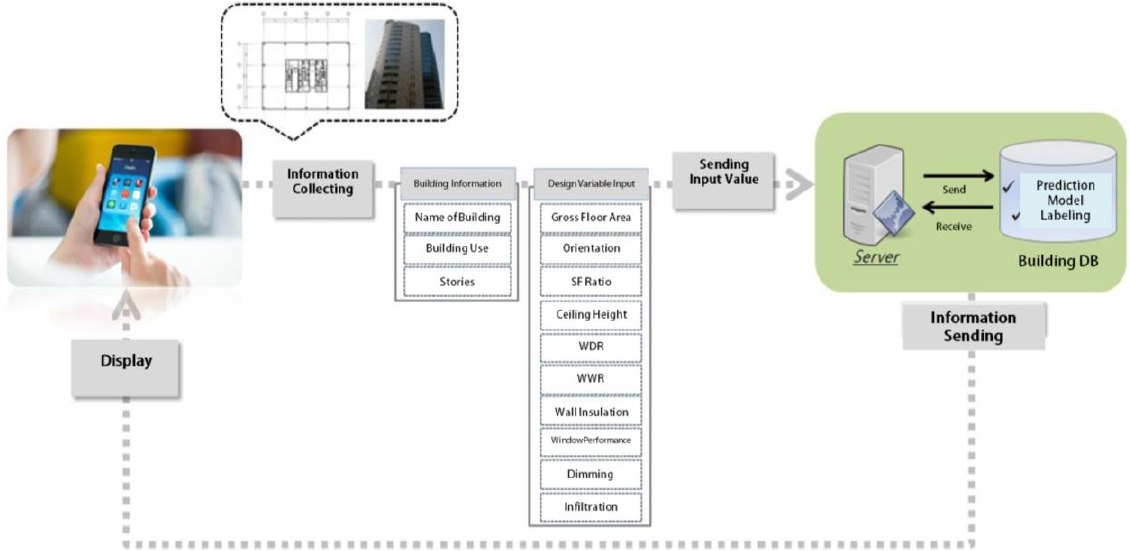
Figure 4. Concept Diagram of Mobile Application.